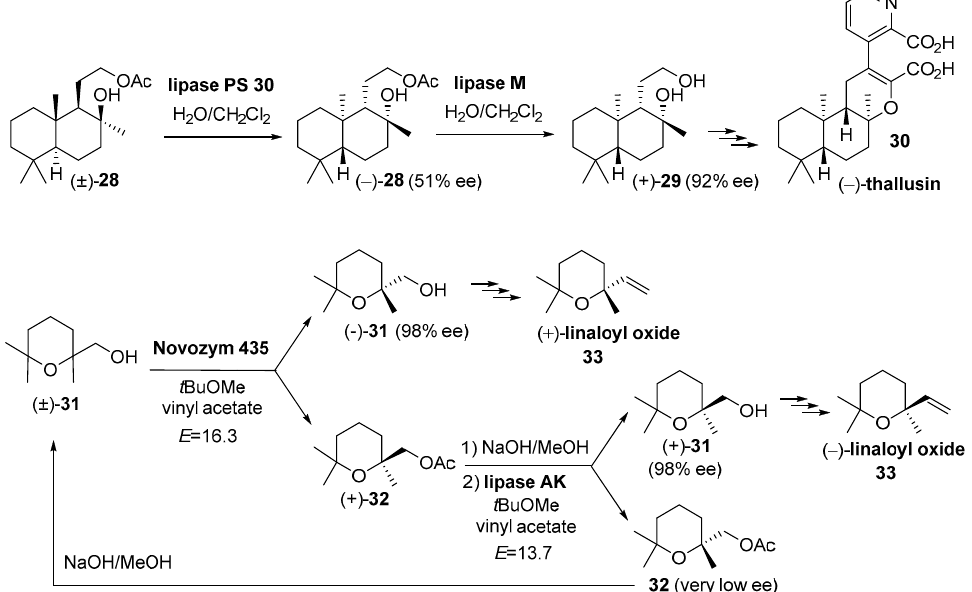
Figure 6. Example of resolution procedures that exploit the opposite selectivity of two di ff erent enzymes. Preparation of the two synthetic building blocks, 29 and 31 , that were used for the synthesis of the terpenoids ( − )-thallusin 30 and the enantiomers of the monoterpene linaloyl oxide 33 ,